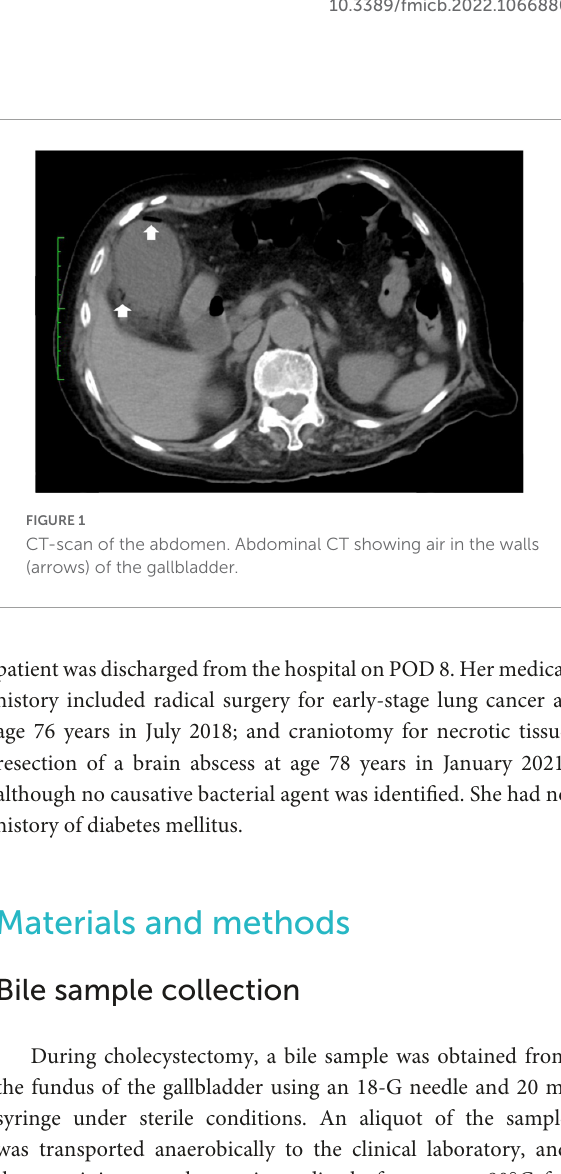
patient was discharged from the hospital on POD 8. Her medical history included radical surgery for early-stage lung cancer at age 76 years in July 2018; and craniotomy for necrotic tissue resection of a brain abscess at age 78 years in January 2021, although no causative bacterial agent was identified. She had no history of diabetes